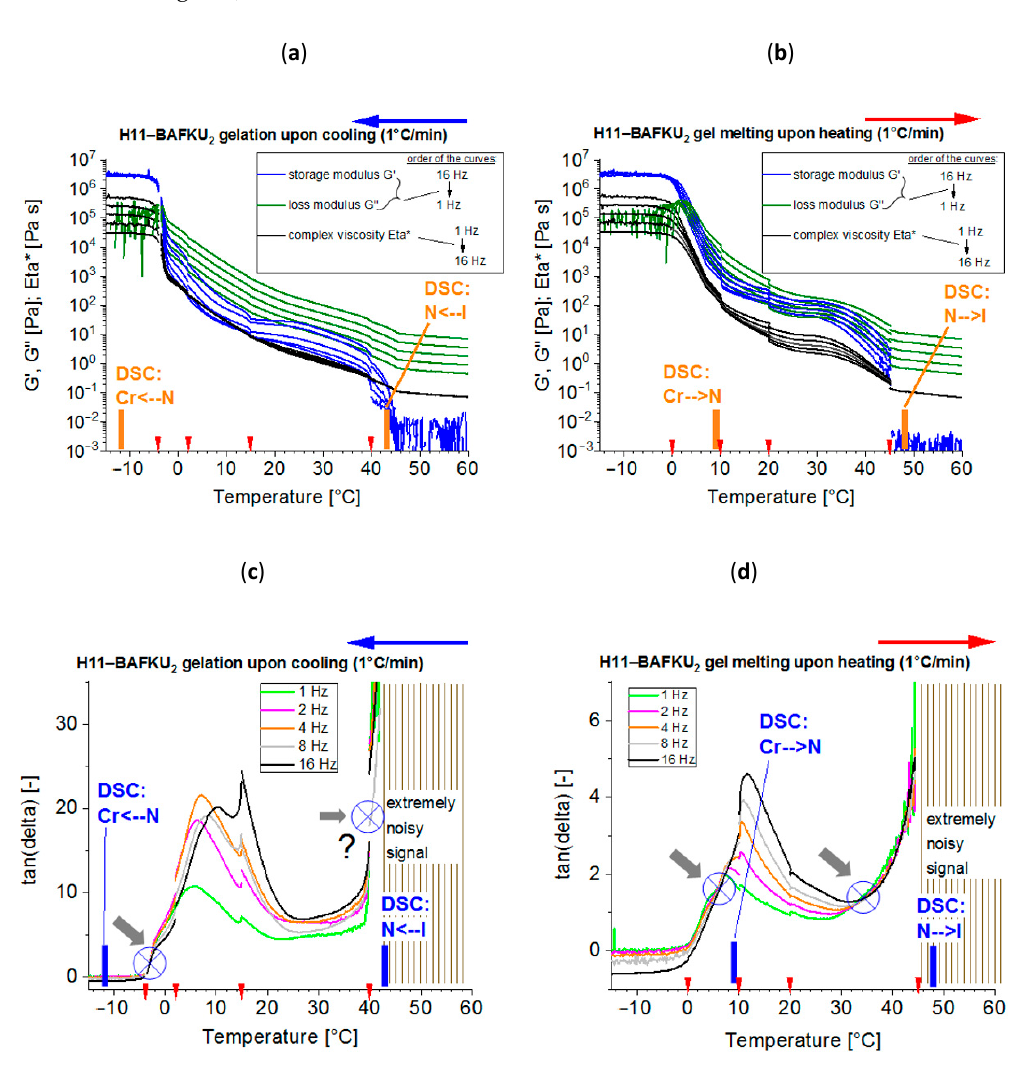
Figure 2. Multi-frequency temperature ramp tests carried out in the melting and rubbery temperature Figure 2. regions of H11–BAFKU 2 : ( a , c ): temperature dependence of the storage shear moduli G (cid:48) of the loss moduli G ” and of the complex viscosities Eta* recorded at the simultaneously applied frequencies of 1, 2, 4, 8 and 16 Hz; ( a ): cooling scan; ( b ): heating scan; ( c , d ): detail of the sets of the tan δ curves with marked crossover (or near-crossover) points; ( c ): cooling scan, ( d ): heating scan; red dotted lines indicate change in